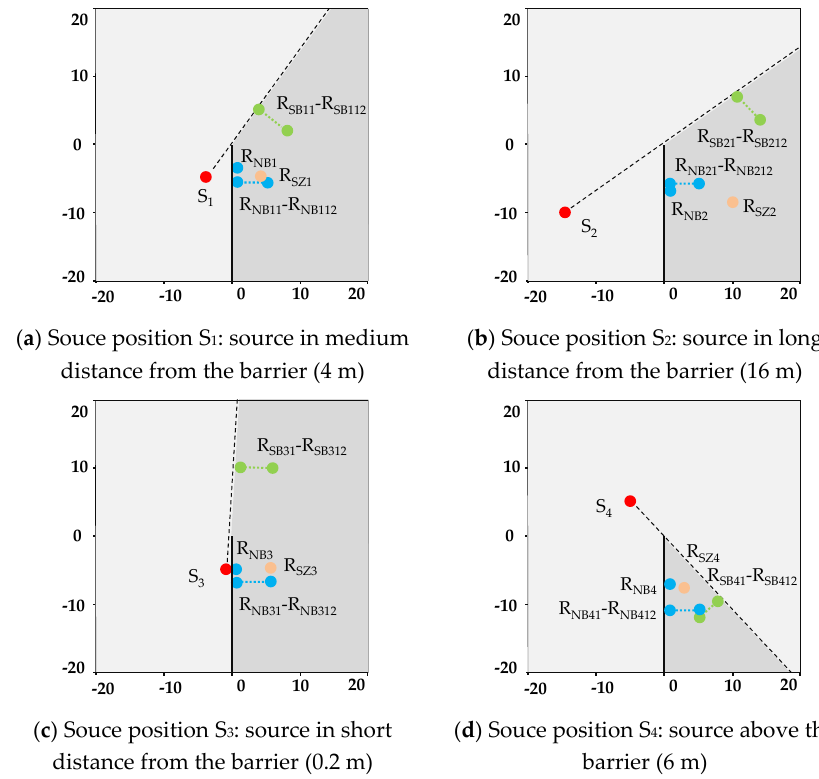
Figure 5. Source and receiver positions for calculation of insertion loss via FEM and various formulae (source (S): red, receiver in the shadow zone (R SZ ): orange, receiver near shadow border (R SB ): green, receiver near barrier (R NB ): blue). The exact positions for each source and receiver are presented in the